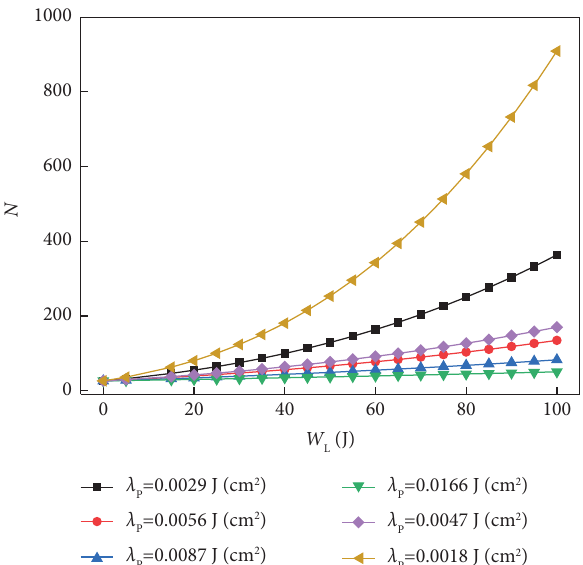
Figure 16: Relationship between concrete breakage degree and dissipative energy with diferent surface specifc